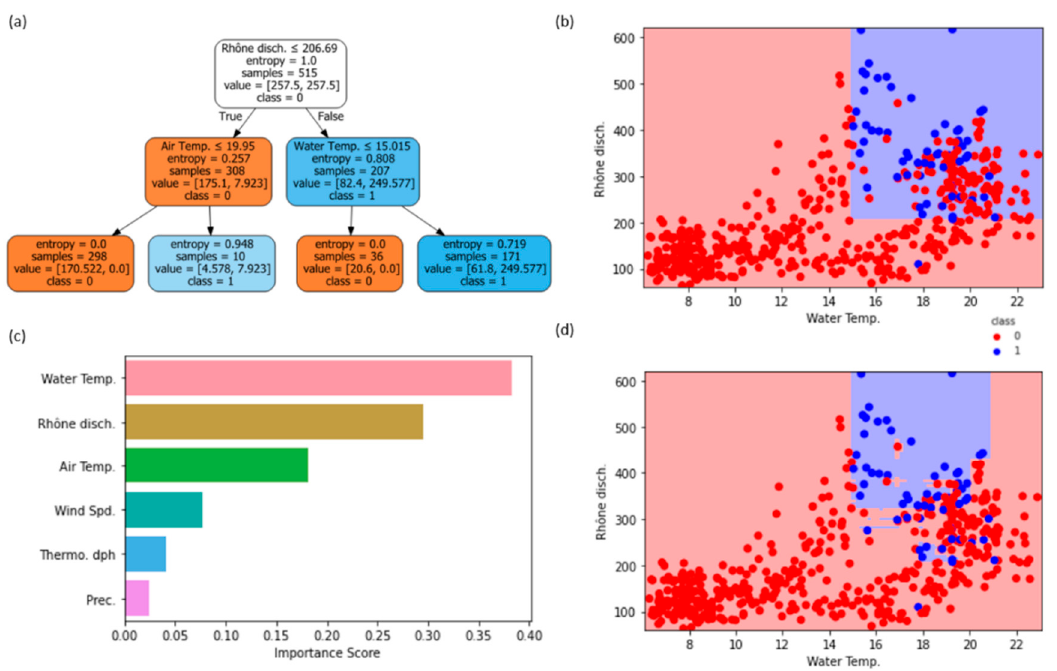
Figure 6. ( a ) Decision tree used to classify the class 1 whiting days between 2013 and 2021 based on the surface water temperature (°C, 0–10 m depth) and the Rhone discharge (m 3 s − 1 ). ( b ) Results of the classification based on the DT shown in ( a ). Whitings and non-whitings events (from the training set) are shown as blue and red dots, respectively. The whitings and non-whitings decision zones predicted by the DT in ( a ) are the areas in blue and red, respectively. ( c ) RF’s important features. ( d ) Same as ( b ) but using the RF algorithm with only the two most important features.